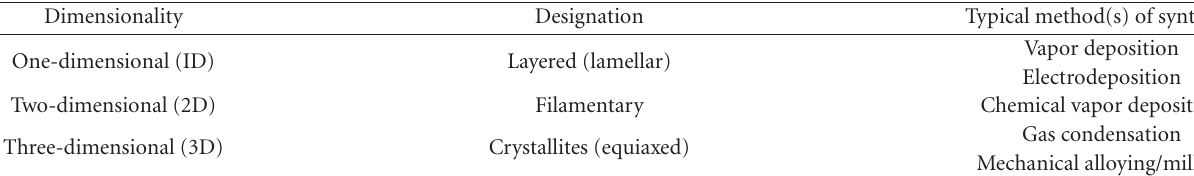
Table 1: Classification of nanocrystalline materials.